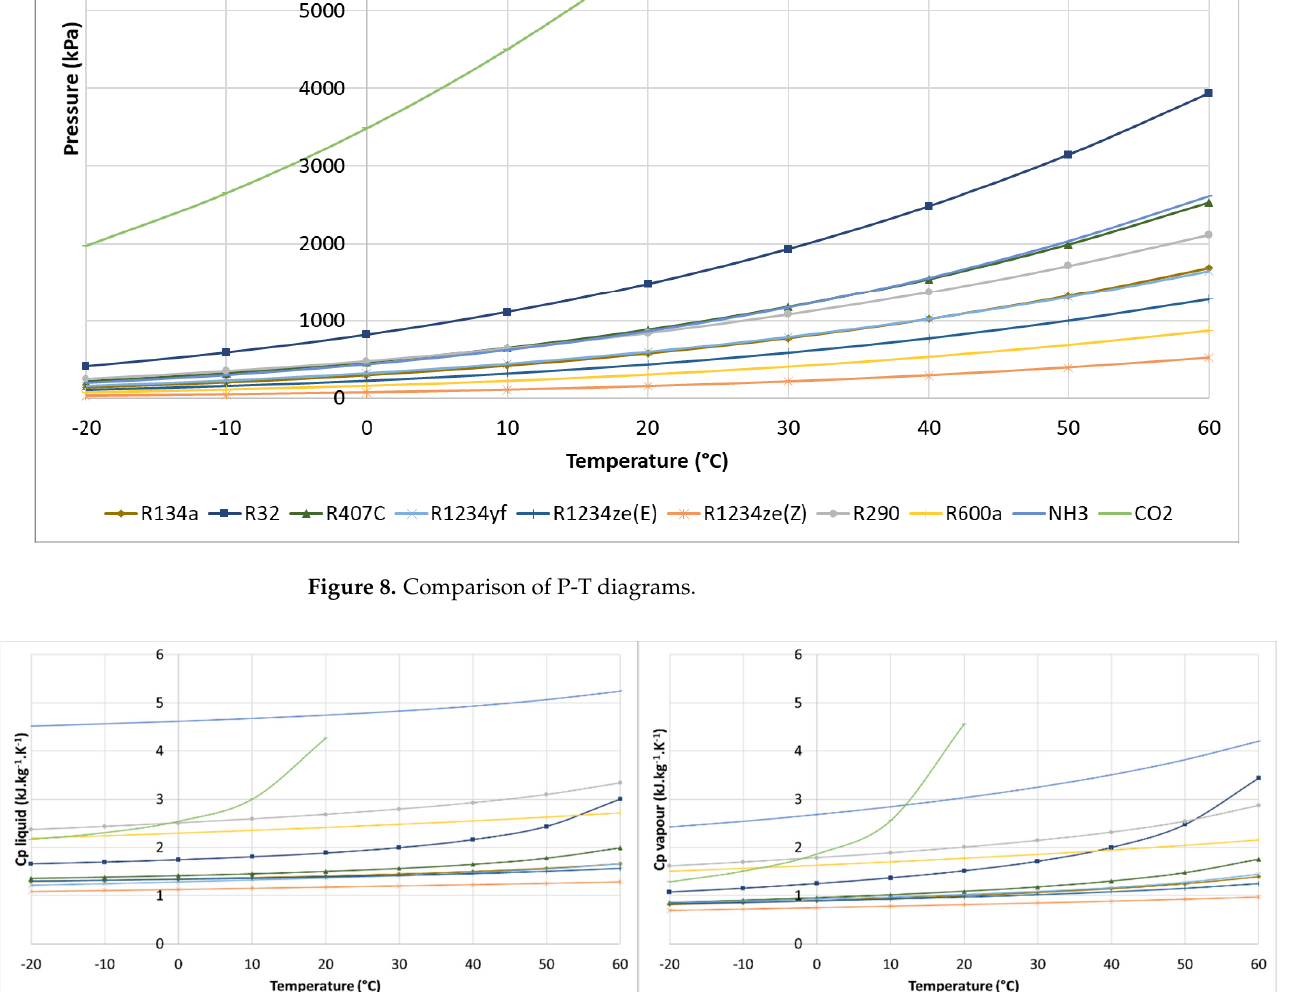
Figure 10. Comparison of evolutions of thermal conductivity depending on temperature. Figure 11. Comparison of evolutions of viscosity depending on temperature. 3.5. Comparison of Refrigerants through Cycle Performance The performances of the thermodynamic cycles of the refrigerants presented in Table 8 are compared for three applications: production of hot water at 35 °C and cold water at 7 °C, for space heating and cooling and domestic hot water production at 55 °C according to the temperatures imposed by the standard tests of regulations EN14511 [47] and